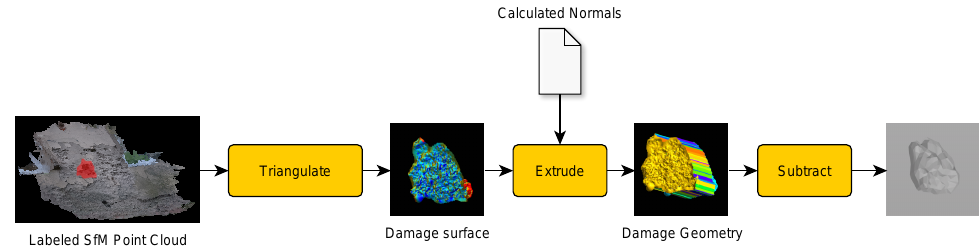
Figure 6. Workflow of the geometry generation with triangulation and